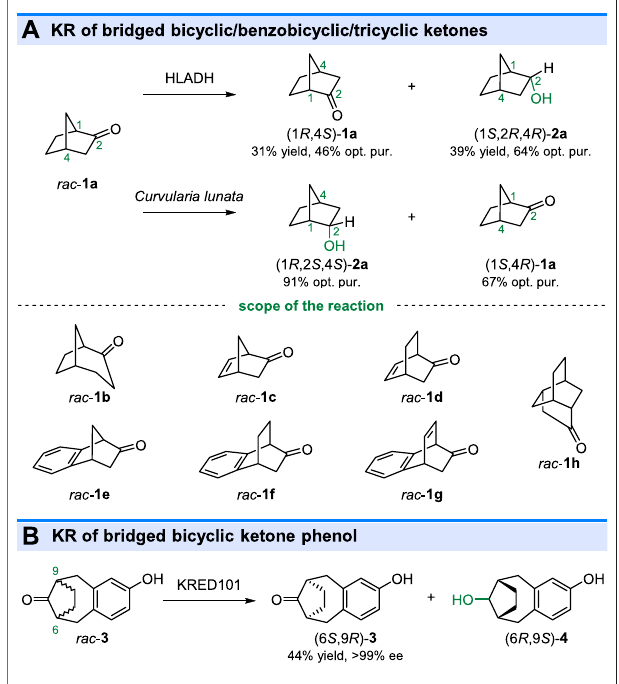
FIGURE 2 | Kinetic resolution of (A) bridged bicyclic/benzobicyclic/ tricyclic ketones and (B) bridged bicyclic ketone